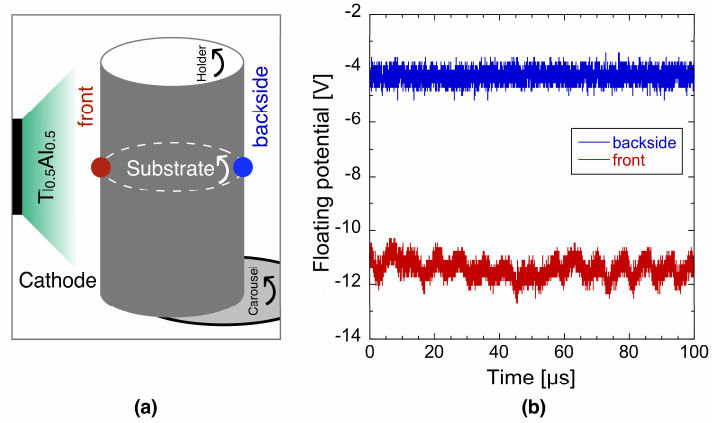
Figure 4. ( a ) Deposition setup scheme indicating the positions for the time-resolved floating potential measurements in ( b ).